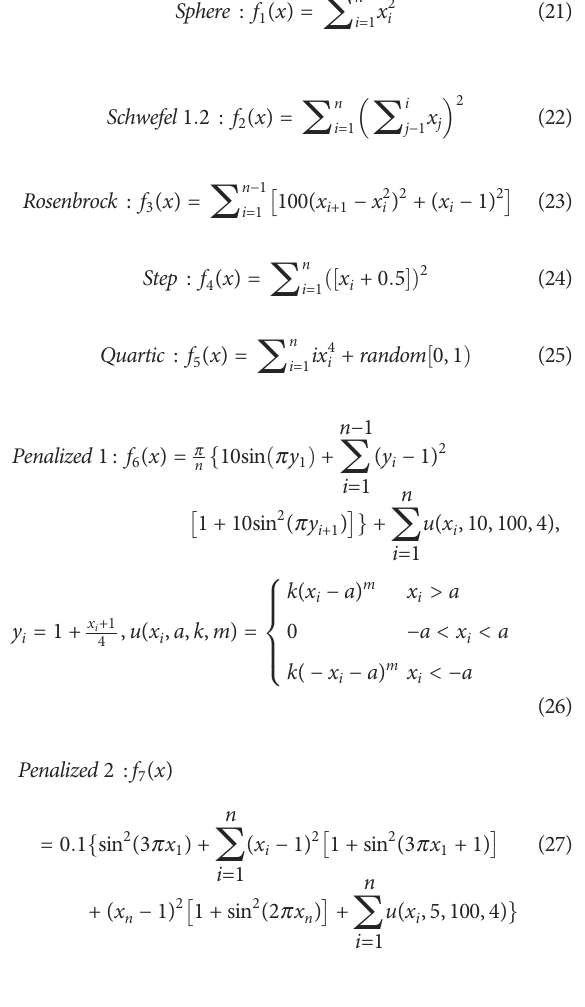
TABLE 2 Eight benchmark